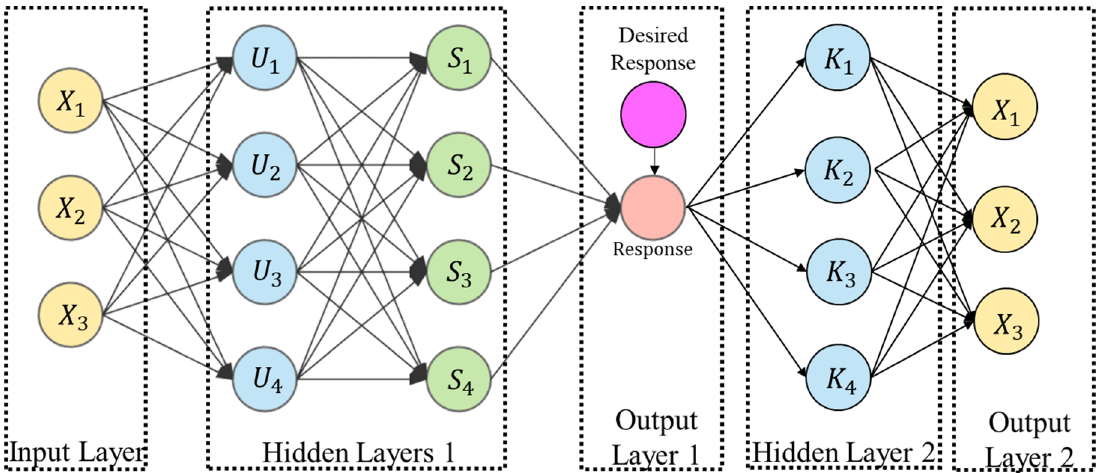
Figure 3. A machine learning framework for quantitatively analyzing deposition shape.